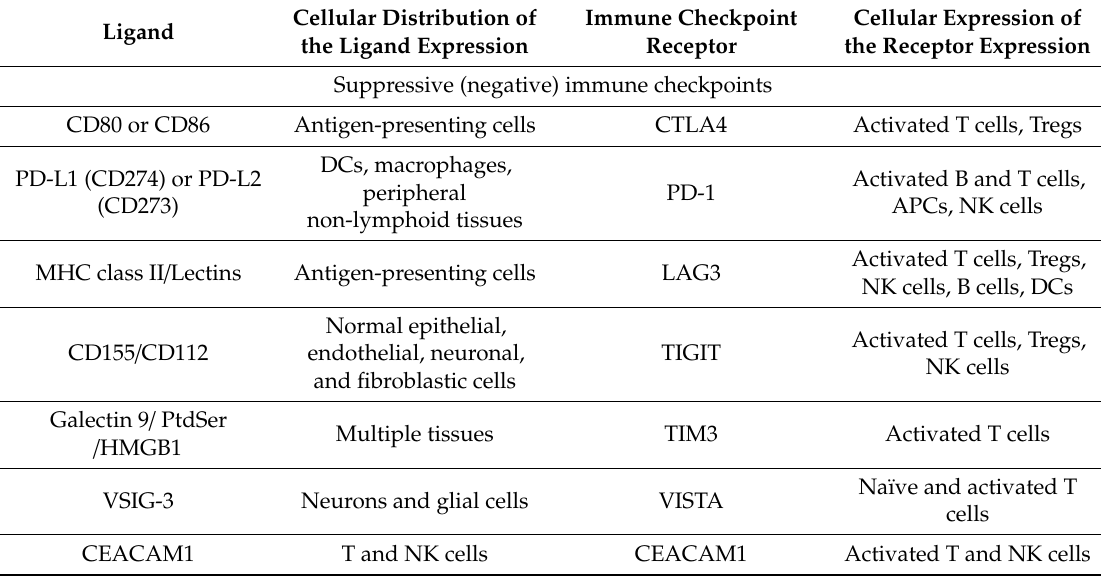
Examples of suppressive (negative) and stimulatory (positive) immune checkpoint ligand–receptor pairs with cellular distribution of these molecules under physiological